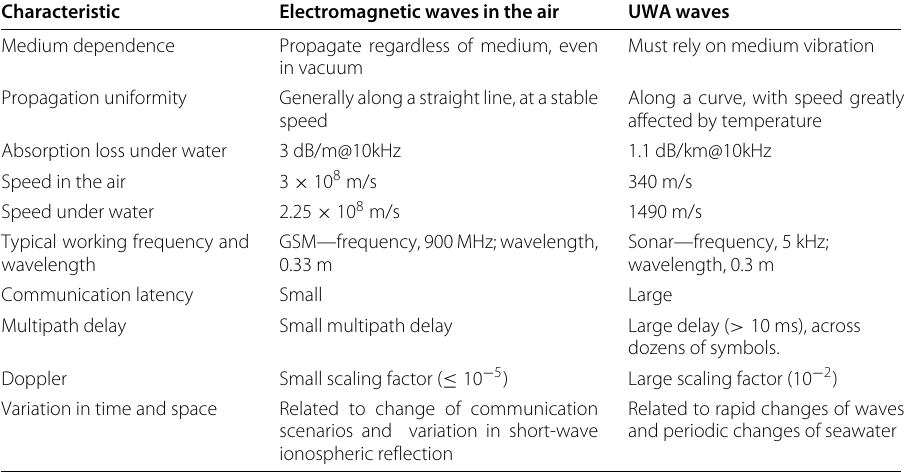
Characteristic Electromagnetic waves in the air Medium